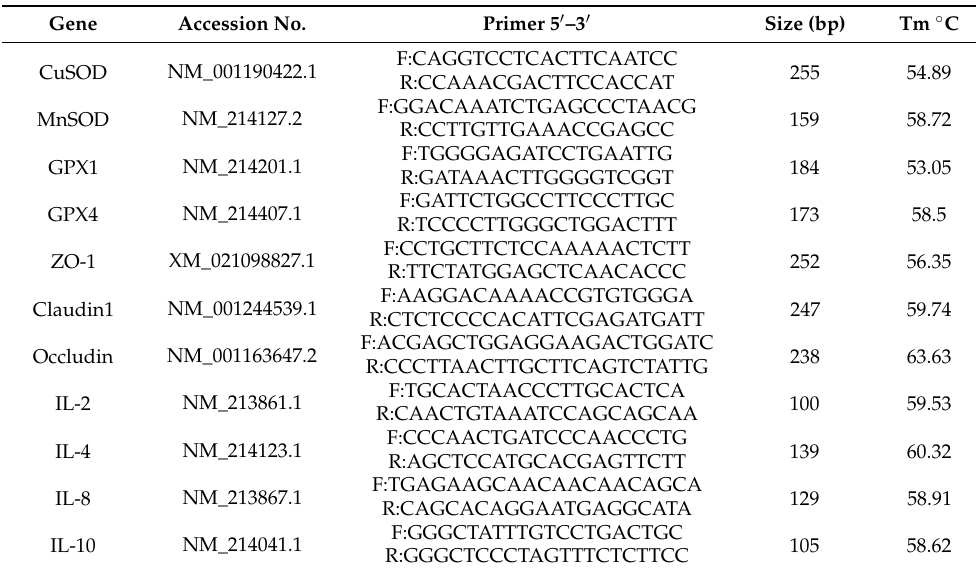
Table 2. The sequences of the primers used for quantitative real-time polymerase chain reac- tion